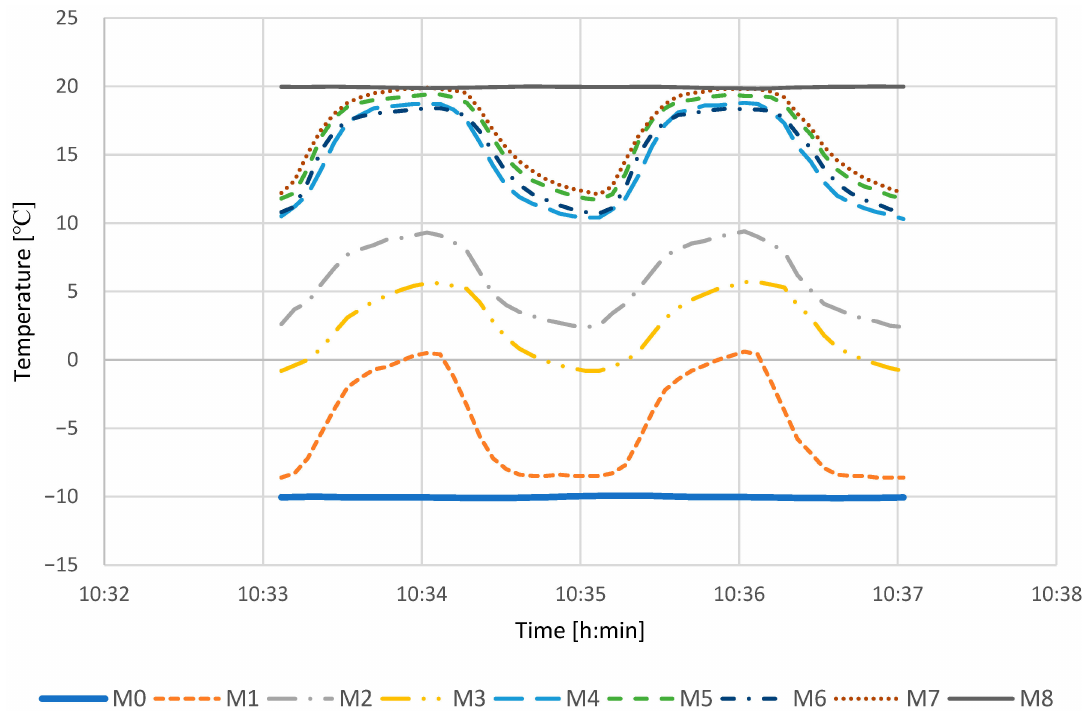
Figure 13. Change in temperature in measuring points marked M0–M8, when the first heat exchanger filled with jojoba oil was used. The external temperature equals − 10 ◦ C and internal temperature equals 20 ◦ C. The supply and exhaust cycles were 1 min.